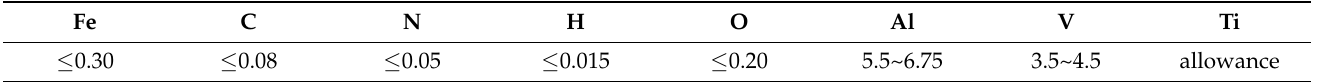
Table 1. Chemical composition of Ti6Al4V titanium alloy (weight %).